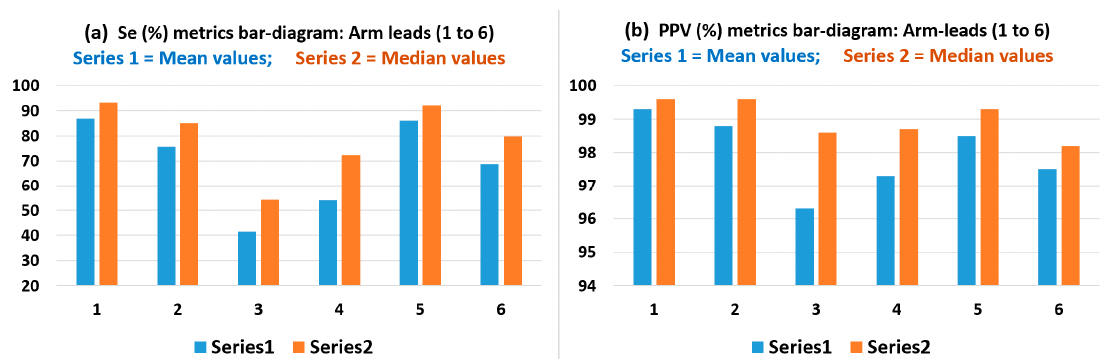
Figure 5. Bar charts presentation with amplified scale ranges (zoom-in) to facilitate depicting performance differentiation between arm leads of the Se (%) and PPV (%) mean and median value results in Table 4.